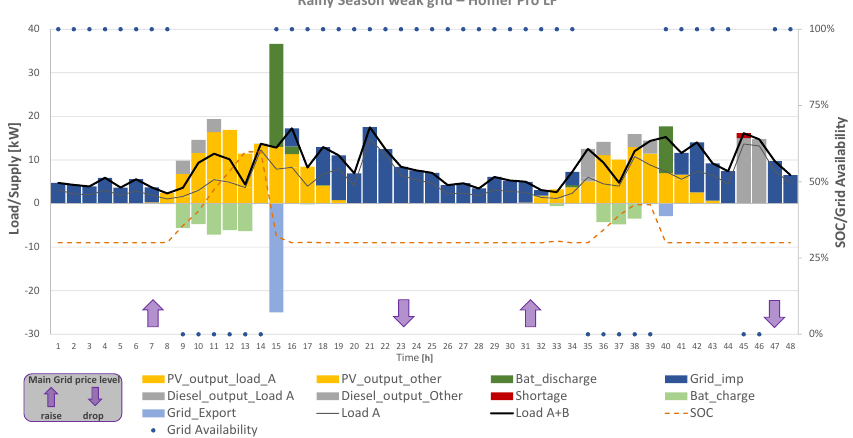
Figure 15. HOMER Pro’s LF strategy for rainy season Unreliable